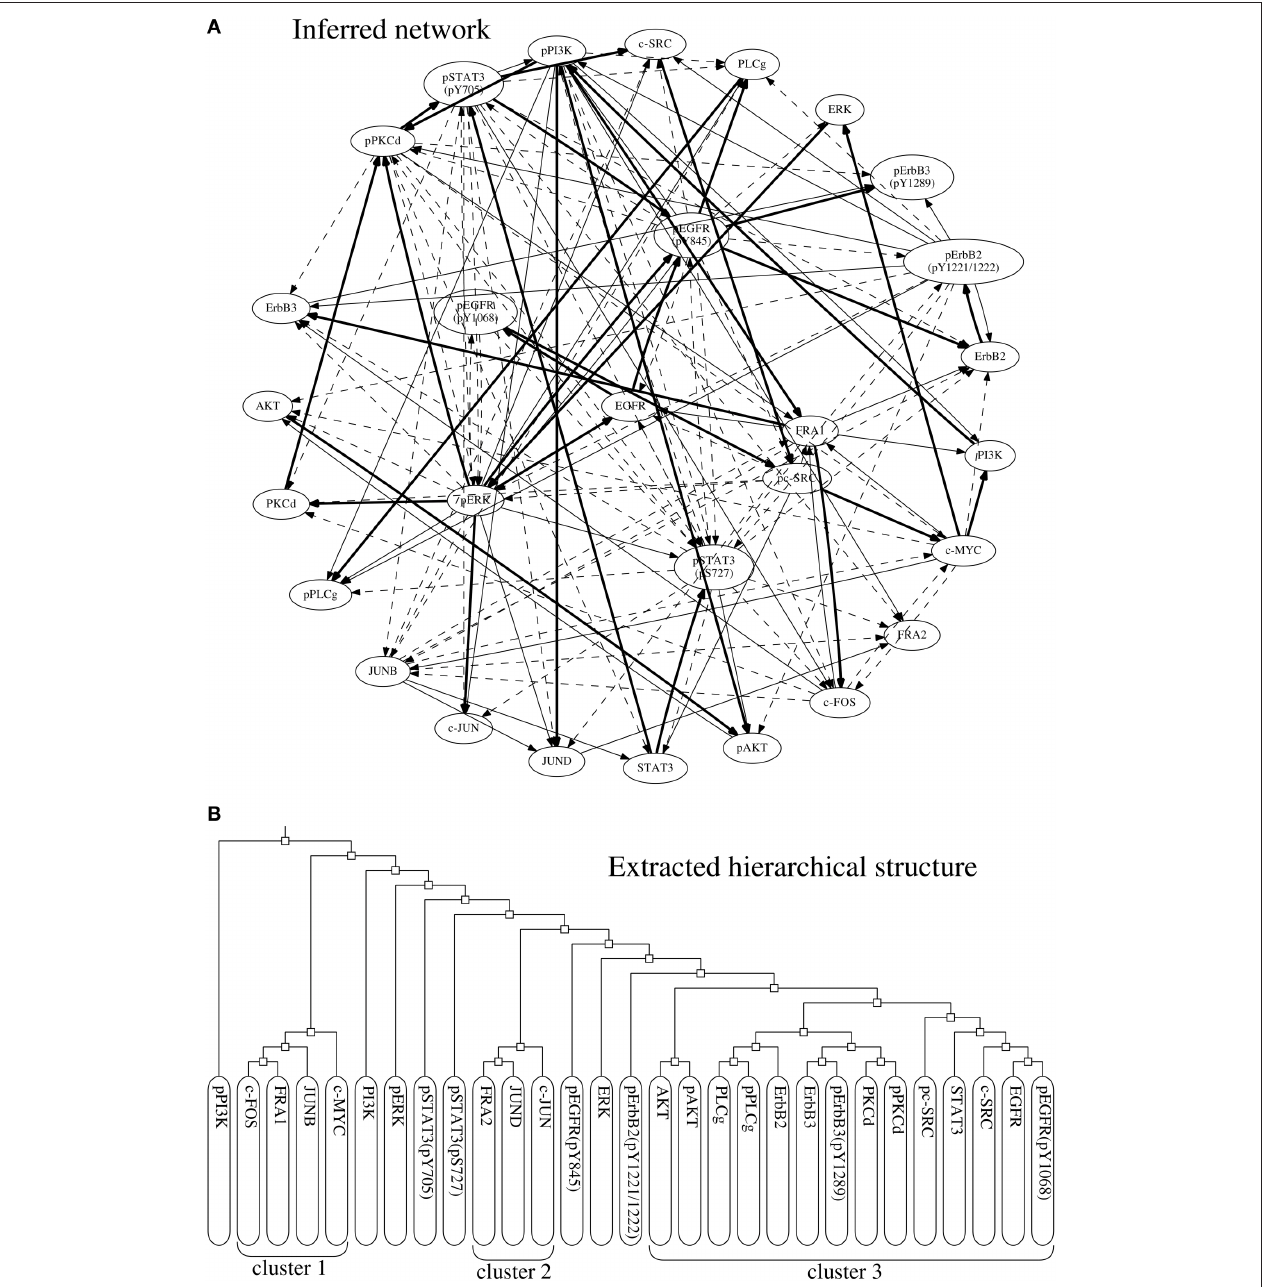
FIGURE 8 | (A) The network of regulations with confidence values exceeding 0.25 . Bold, solid, and dotted lines represent regulations with confidence values exceeding 0.75 , 0.5 , and 0.25 , respectively. (B) The hierarchical structure extracted from the inferred